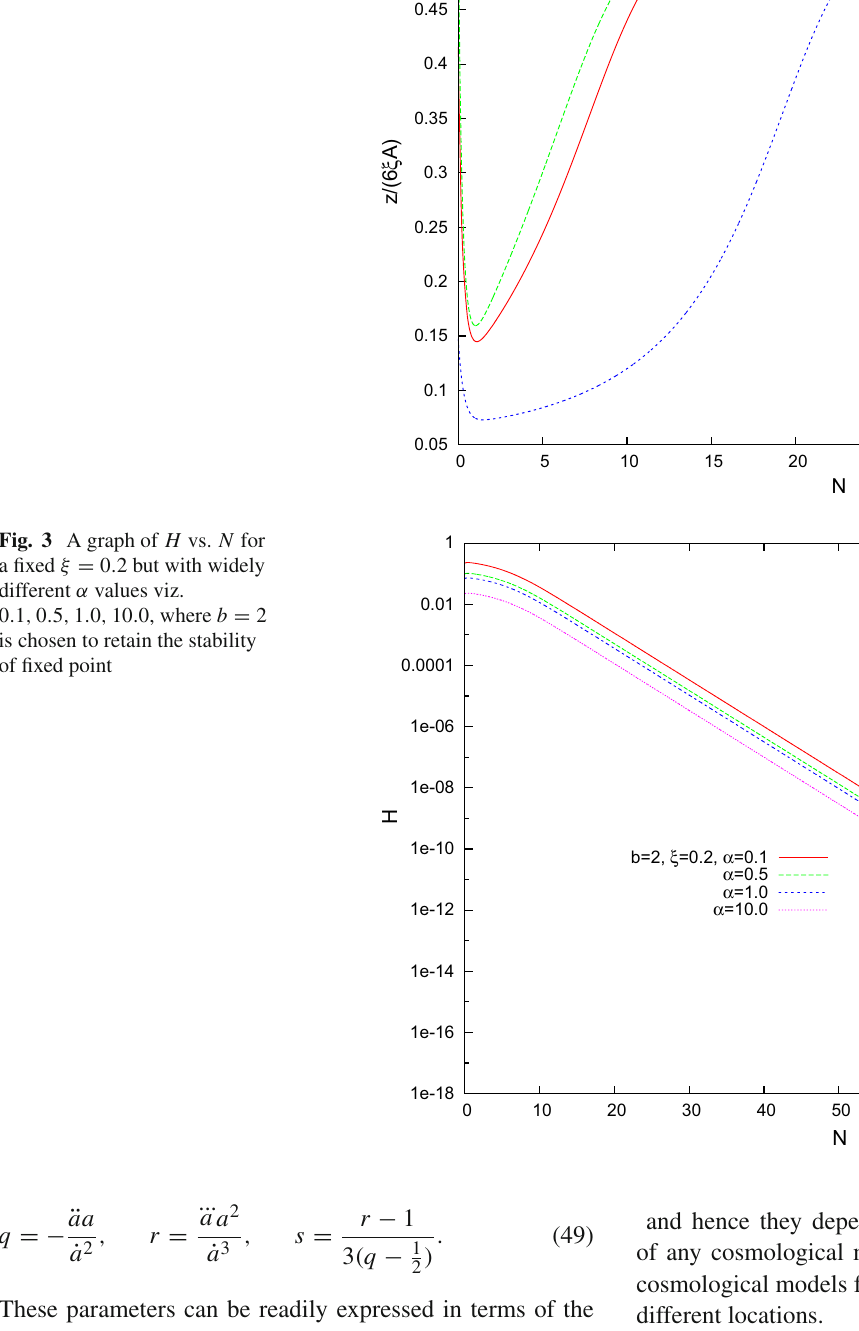
Fig. 3 A graph of H vs. N for a fixed ξ = 0 . 2 but with widely different α values